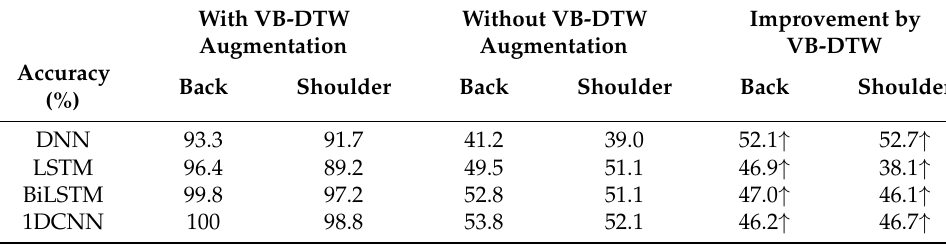
Table 5. Test result of the effectiveness of data